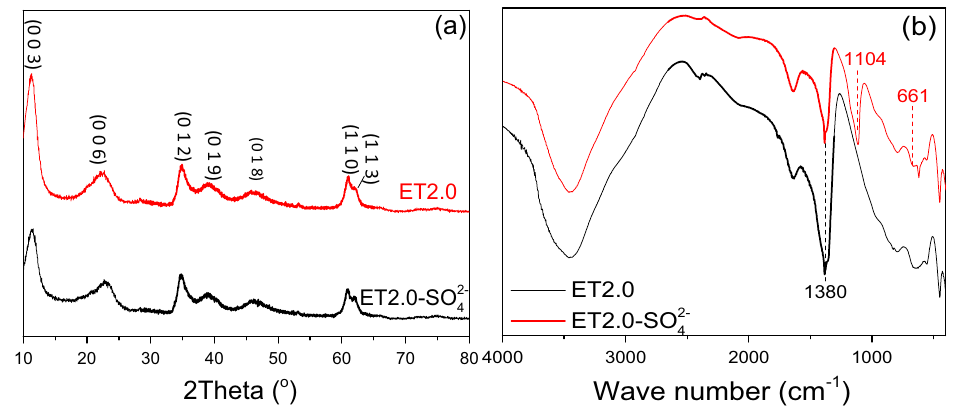
Figure 8: ( a ) XRD and ( b ) FT - IR of ET2.0 and ET2.0 - SO 42−